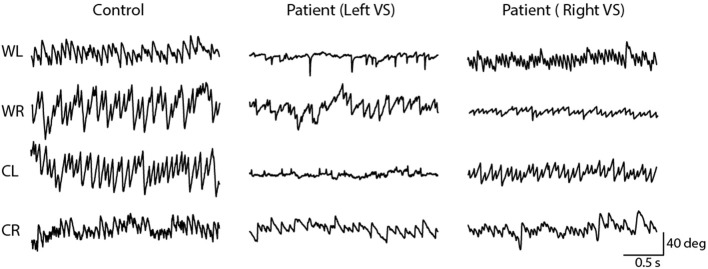
Horizontal nystagmus evoked by caloric stimulation. The direction (down; rightwards, up; leftwards) of the slow phase is dependent on the ear and temperature. A controls subject's responses produced similar slow phase velocity during left and right ear stimulation. However, vestibular schwannoma patients show an attenuated response during ipsilesional stimulation.